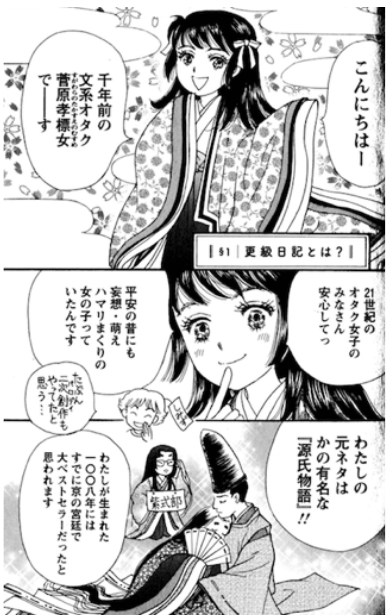
Figure 10. Opening page of manga